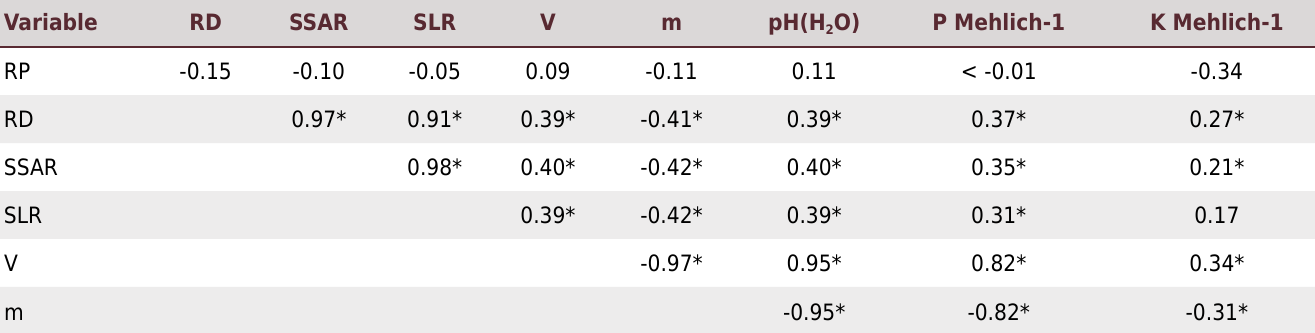
Table 1. Spearman correlation coefficients between soil properties and root distribution in the soil of ‘Maciel’ peach trees grafted onto ‘Okinawa’ and